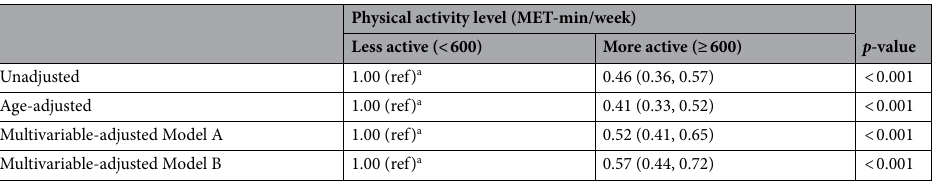
Table 2. Odds ratio (95% CI) for depression according to physical activity levels. Data are representative of non-institutionalized American population. Model A is adjusted by age, sex, race/ethnicity, annual household income, and educational level. Model B is additionally adjusted by alcohol consumption, smoking status, BMI, arterial hypertension, dyslipidemia, and diabetes. a Significant differences between Less-active and More-active groups.